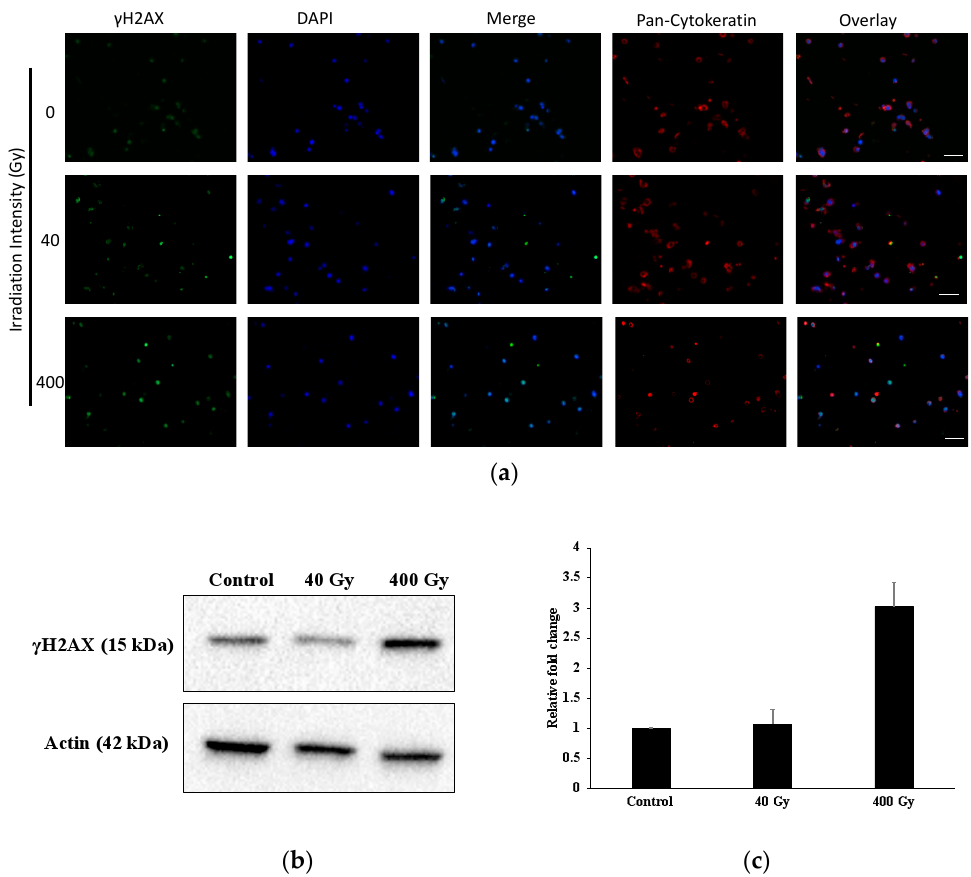
Figure 4. Bioprinted A549 cells immuno-stained against γ H2AX following irradiation with an array of microbeams ( a ) and results of the immunoblot ( b , c ). ( a ) Shown are 10 µm sections of hydrogel- based 3D matrices generated from A549 lung cancer cells, fixed at 36 h after irradiation with peak doses of either 40 Gy or 400 Gy, as indicated. The γ H2AX staining (green channel) indicates DNA double-strand breaks. The samples were also stained with an antibodies against pan-cytokeratin to confirm their character as epithelial cells (red channel). DAPI was used for nuclear counterstaining (blue channel). Scale bar: 50 µ m. ( b ) Control and irradiated (40 and 400 Gy) samples were harvested 36 h after irradiation and subjected to immunoblot analysis for γ H2AX and β -actin. The results are representative of two independent experiments. ( c ) The band densities from ( b ) were quantified and normalized to corresponding band densities of the β -actin loading control. Alterations in expression levels in the samples irradiated with MBI peak doses of 40 Gy and 400 Gy, compared to non-irradiated controls, are represented as mean fold change ± SD, n =